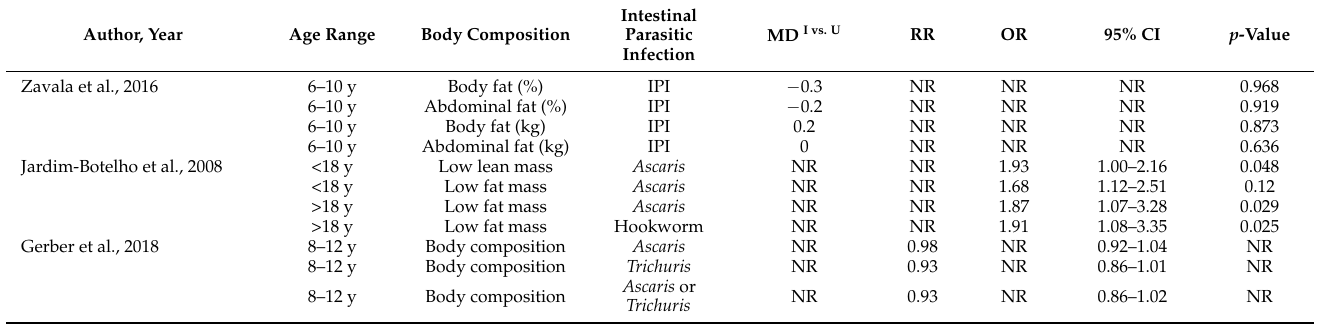
Table 4. Association between intestinal parasite infections and direct measures of body